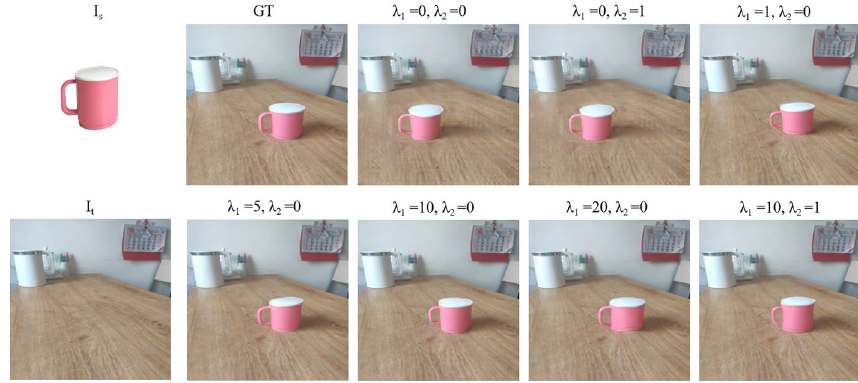
Fig. 4 Results testing on one sample of our approach for multitask compositing network: a source object, b target image, c compositing image, and d ground